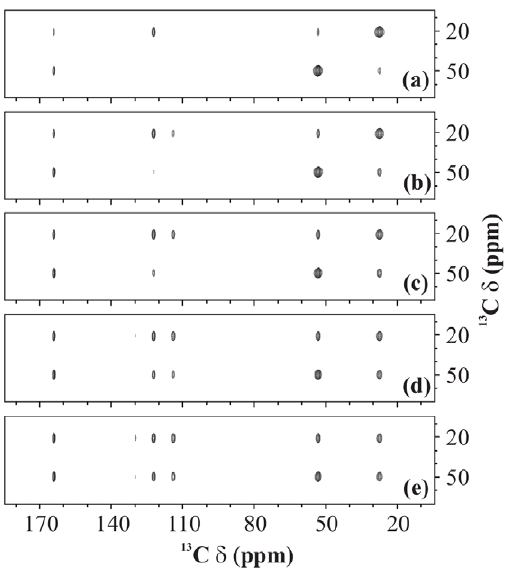
Figure 9. 13 C- 13 C spectra. 2D 13 C- 13 C spectrum of U- 13 C-, 15 N-L- histidine : H 2 O recorded using PARIS-xy (m=1)(N=1/2) recoupling scheme at B 0 =11.74 T, n r =30 kHz, n 1 H =16 kHz, and with (a) 10, (b) 20, (c) 40, (d) 80, and (e) 160 ms long mixing-time period.